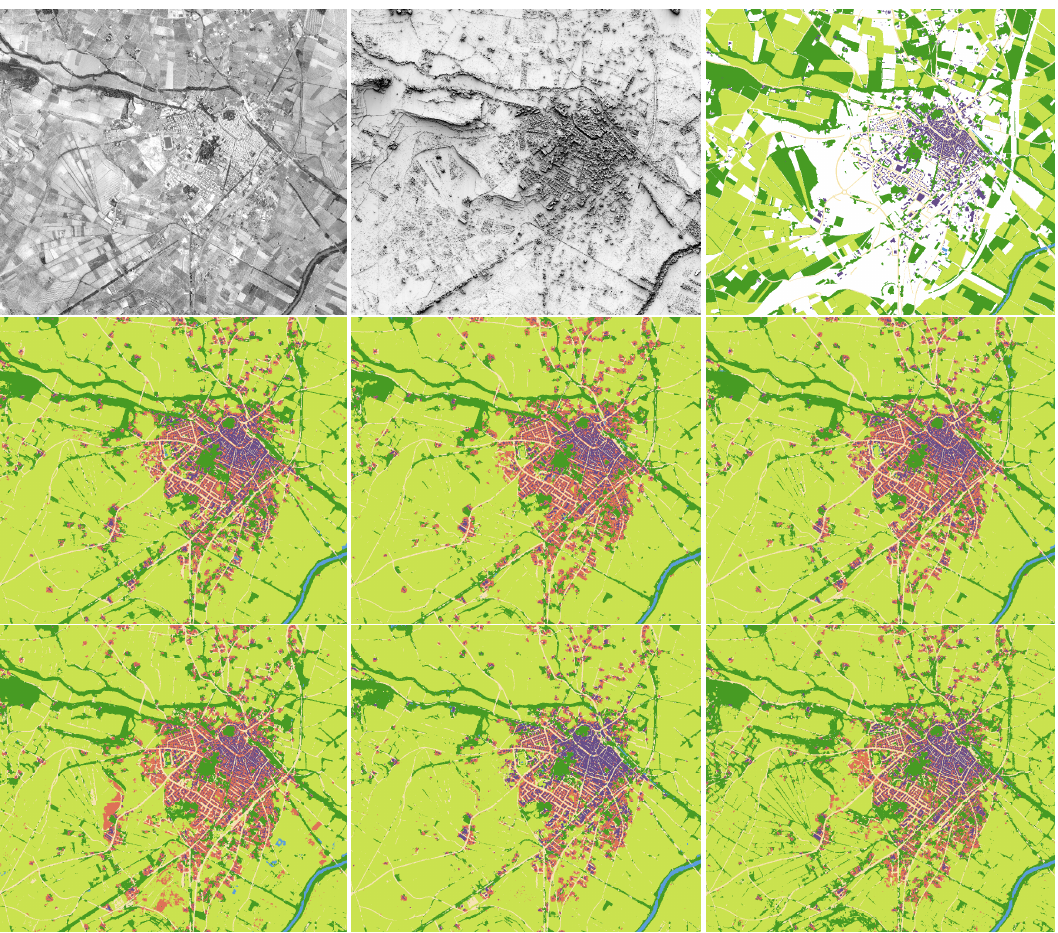
Figure 5. 1981: (from left to right) top row: ortho-image, shading map, cleaned ground truth; middle row: UNet:im, UNet:im+dsm, UNet:im+sh; bottom row: FuseNet:im+dsm, FuseNet:im+sh,